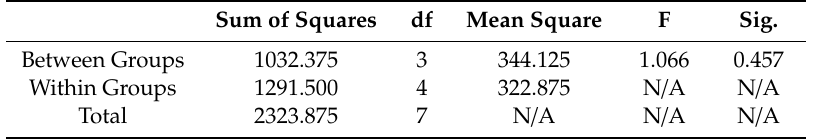
Table A3. ANOVA analysis for maximum power densities (mW / m 3 ) of the microbial fuel cell (MFC) reactors with the cathode electrodes submerged at the proportions of 25%, 50%, 75%, and 100%. Sum of Squares df Mean Square F Sig. Between Groups 1032.375 3 344.125 Within Groups 1291.500 322.875 2323.875